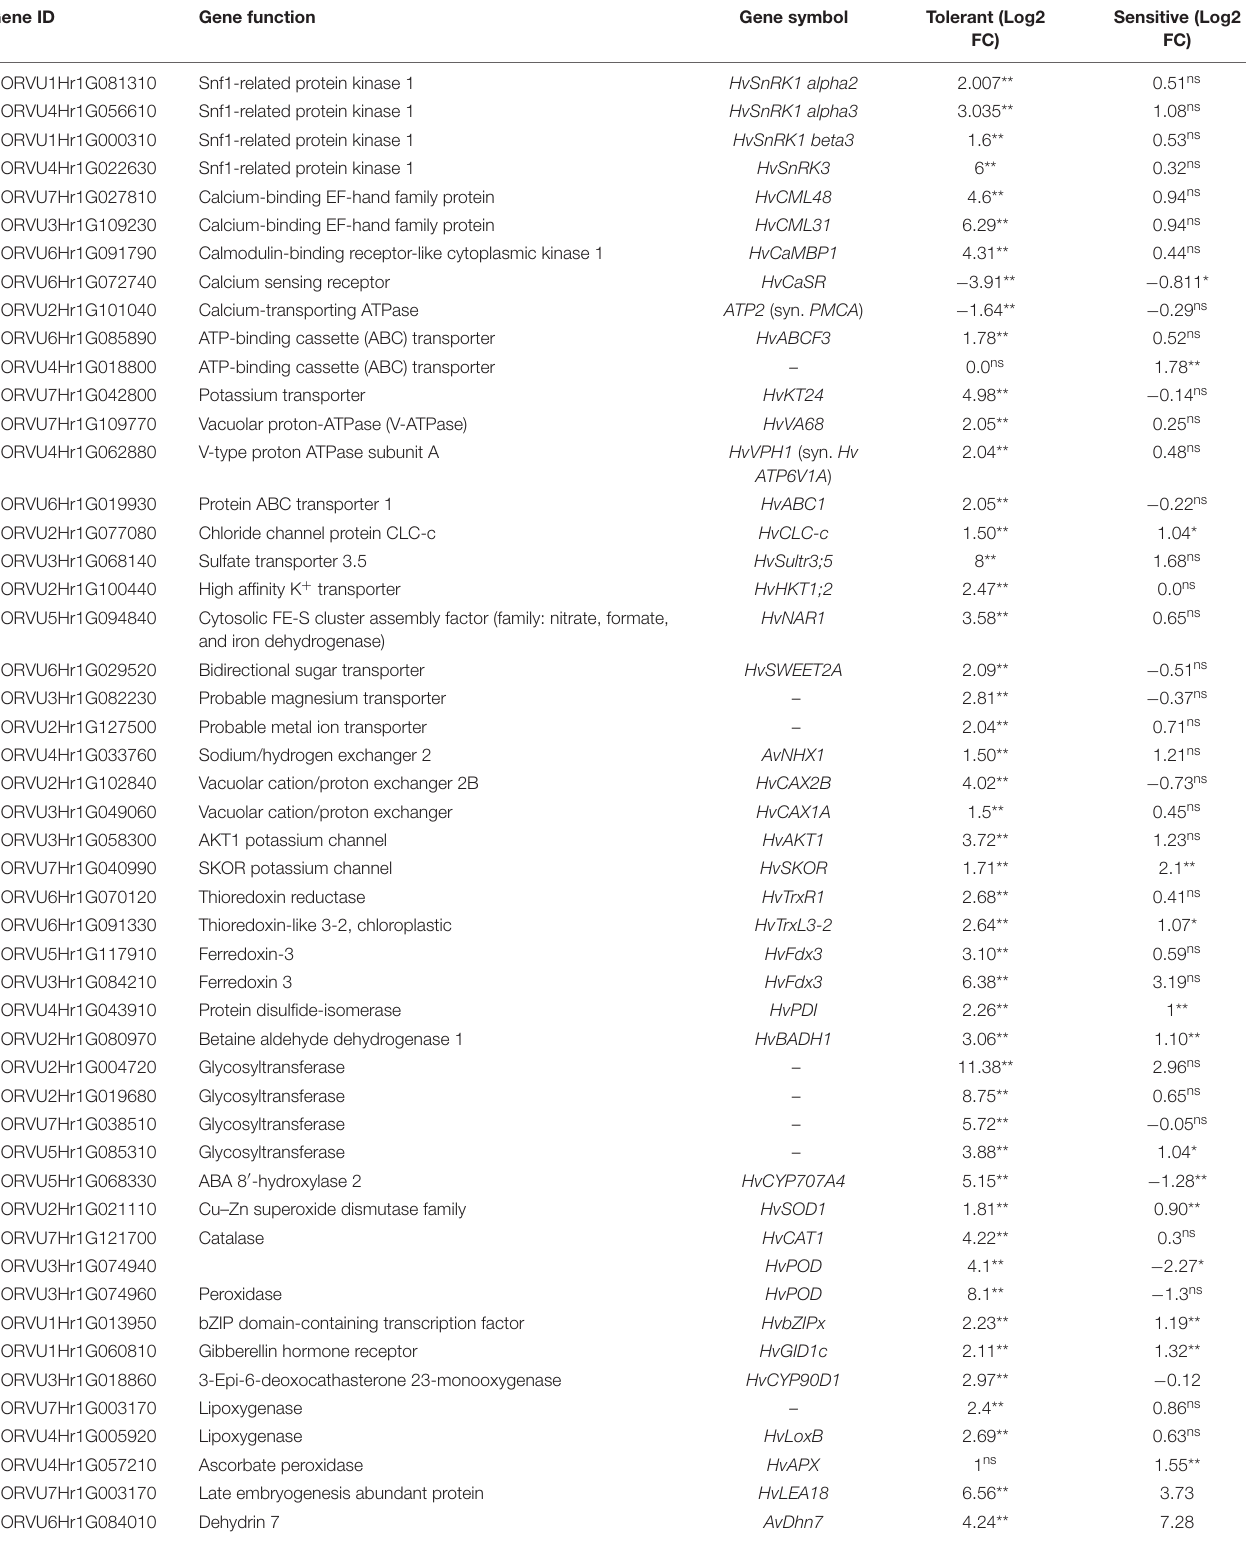
TABLE 4 | Functional annotations of some of the differentially expressed (up- and down-regulated) genes in wild (tolerant) and cultivated (sensitive) genotypes of barley grown under control and salt stress conditions. Gene ID Gene